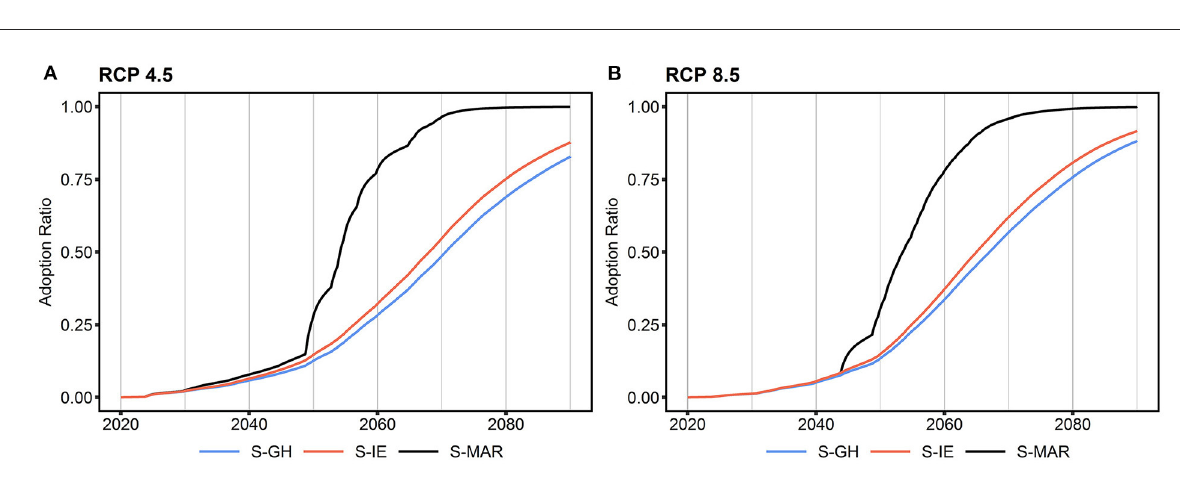
FIGURE11 Adoption ratio for three adaptation methods under (A) RCP 4.5 and (B) RCP